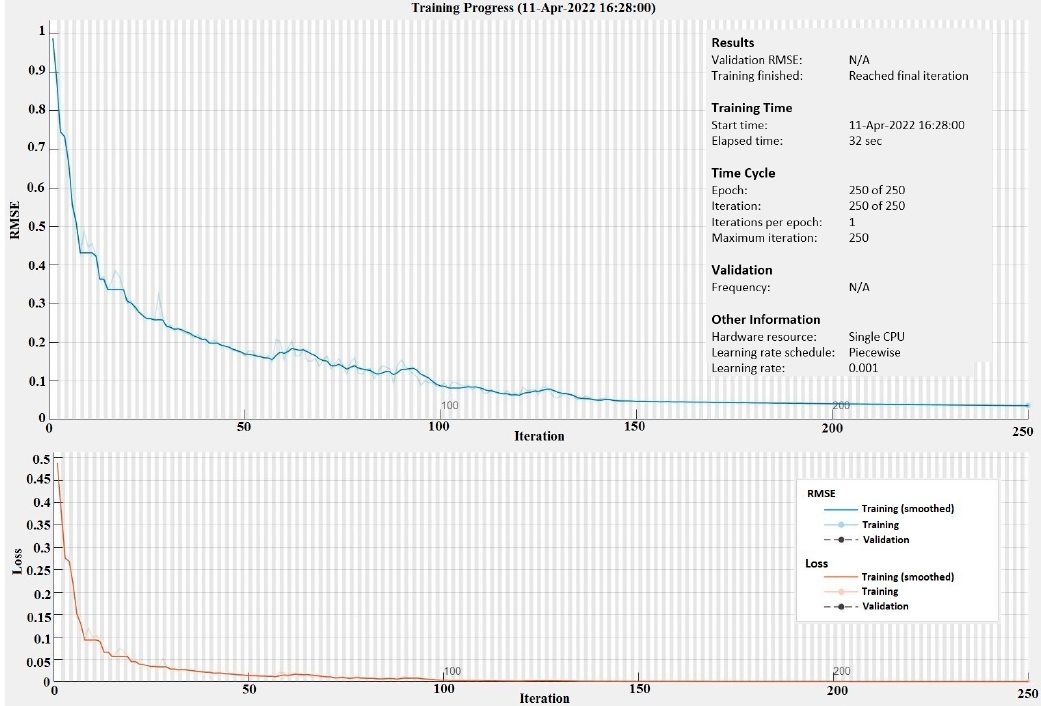
Figure 11. Training progress representation for per-hour forecasting using LSTM-based DNN.